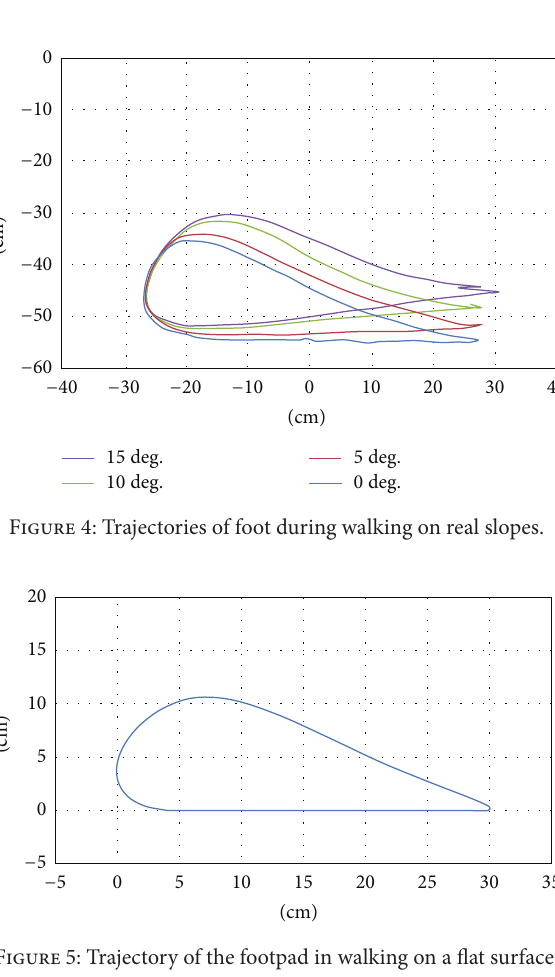
prerecorded absolute positions of the feet. In the stance phase, they were moved